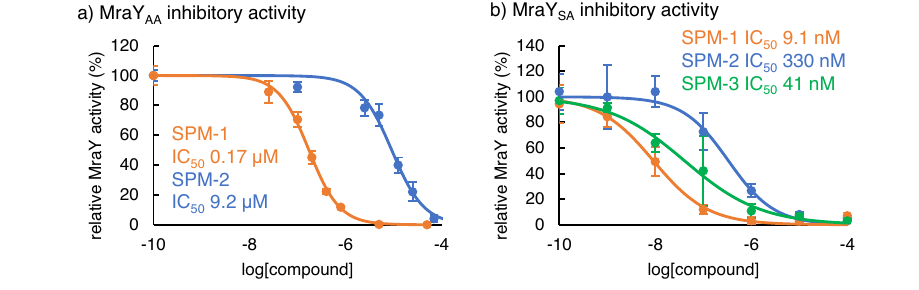
(pH 7.6), 50mM KCl, 25mM MgCl 2 , 0.2% Triton X-100, 8% glycerol, 50 μ M C 55 -P, 10 μ M UDP-MurNAc-dansylpentapeptide, and MraY enzyme (11 μ g/mL, 5 μ L/well). After3 – 4hincubationatroomtemperature,theformationofdansylatedlipidIwas monitored by fl uorescence enhancement (excitation at 355nm, emission at 535nm). The data were obtained from three independent experi- ments and represented as mean±SD. SPM-1 isshown in orange, SPM-2 isshown in blue, and SPM-3 is shown in green throughout.